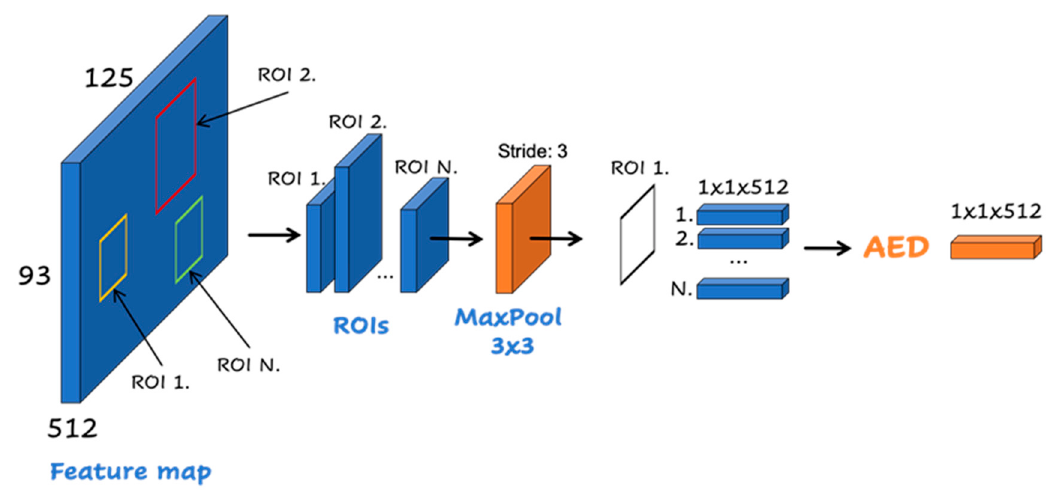
Figure 6. Feature extraction with the ROI MaxPool layer. For each ROI the max pool operation is used to reduce feature space and then the average Euclidean distance to select the best features.